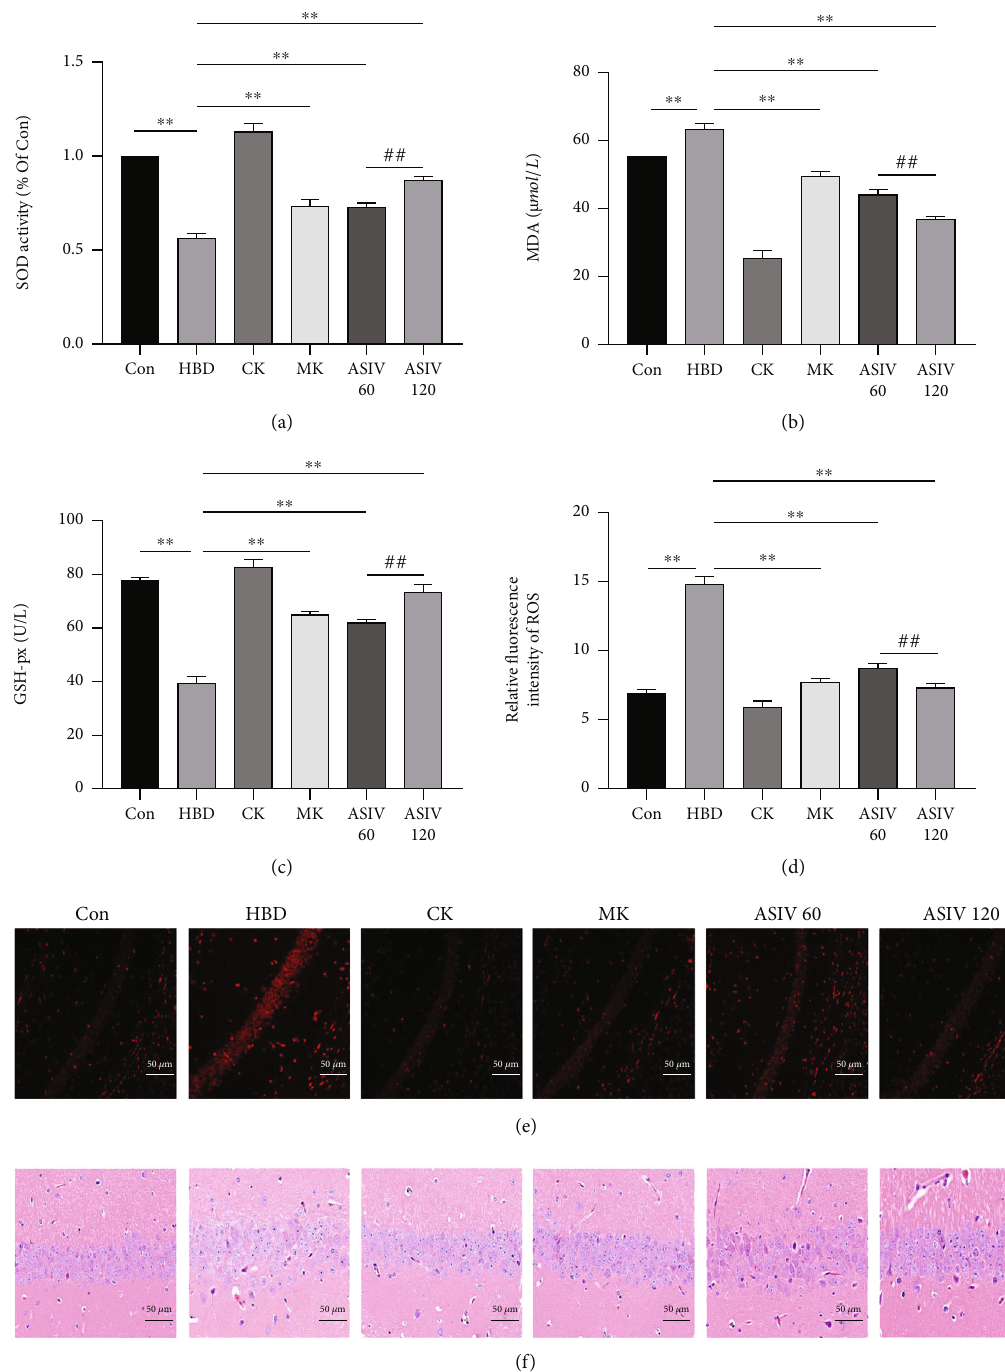
Figure 3: AS-IV and calpain-1 knockout can reduce the oxidative stress of hippocampal CA1 neurons in mice with hypoxic brain injury. (a – c) The changes in SOD, MDA, and GSH-Px were measured by SOD, MDA, and GSH-Px determination kits, respectively ( n = 4 ; SOD, F ð 5,17 Þ = 170 : 353 ; MDA, F ð 5,17 Þ = 280 : 493 ; GSH-Px, F ð 5,17 Þ = 201 : 152 ). (d – e) The DHE probe labeling method was used to observe the production of reactive oxygen species in the hippocampal CA1 region of mice in each group ( n = 3 ; F ð 5,12 Þ = 255 : 003 ). (f) Morphological changes of hippocampal CA1 neurons observed by HE staining ( n = 3 ). Data are presented as the mean ± SD . ∗∗ P < 0 : 01 compared with the HBD group, ## P < 0 : 01 compared with the ASIV 60mg/kg